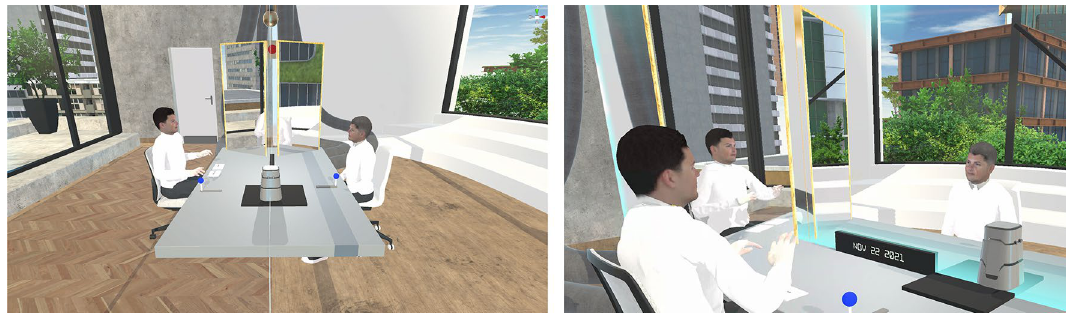
Figure 3. Impressions of the virtual reality environment in which the present self (PS) (left) interacts with his Future Self (FS) avatar (right). The mirrors at the far end of the table serve to foster virtual embodiment. Pushing the blue levers on either side of the table activates the ‘time machine’ to switch perspective from the PS to the FS or vice